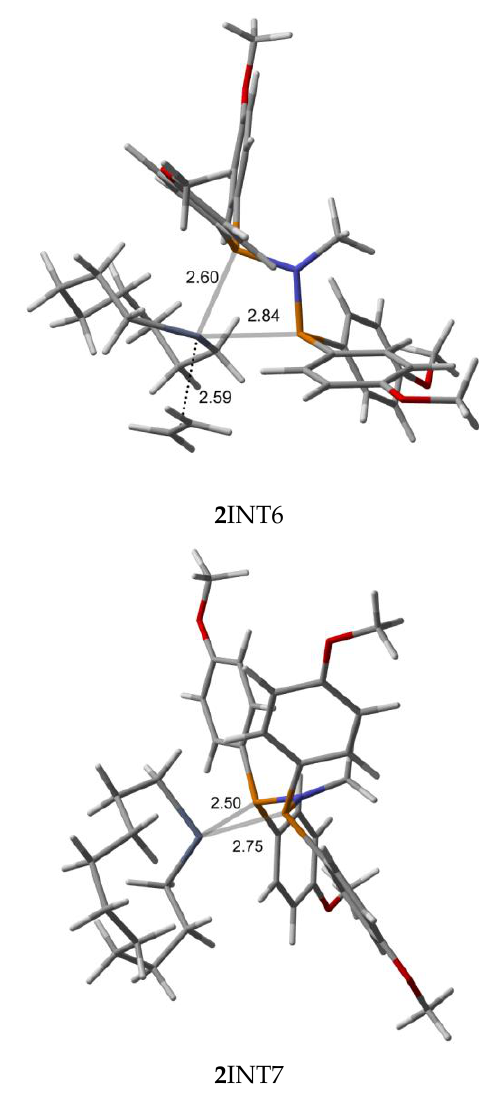
Figure 4. B3LYP/6-31G*/LanL2DZ optimized geometries (Supplementary Material) with important distances (Å) for ethylene trimerization and tetramerization using the para -methoxyaryl Cr-PNP catalyst. (Gray: carbon; red: oxygen; white: hydrogen; orange: phosphorus; blue: nitrogen; dark gray: Cr).